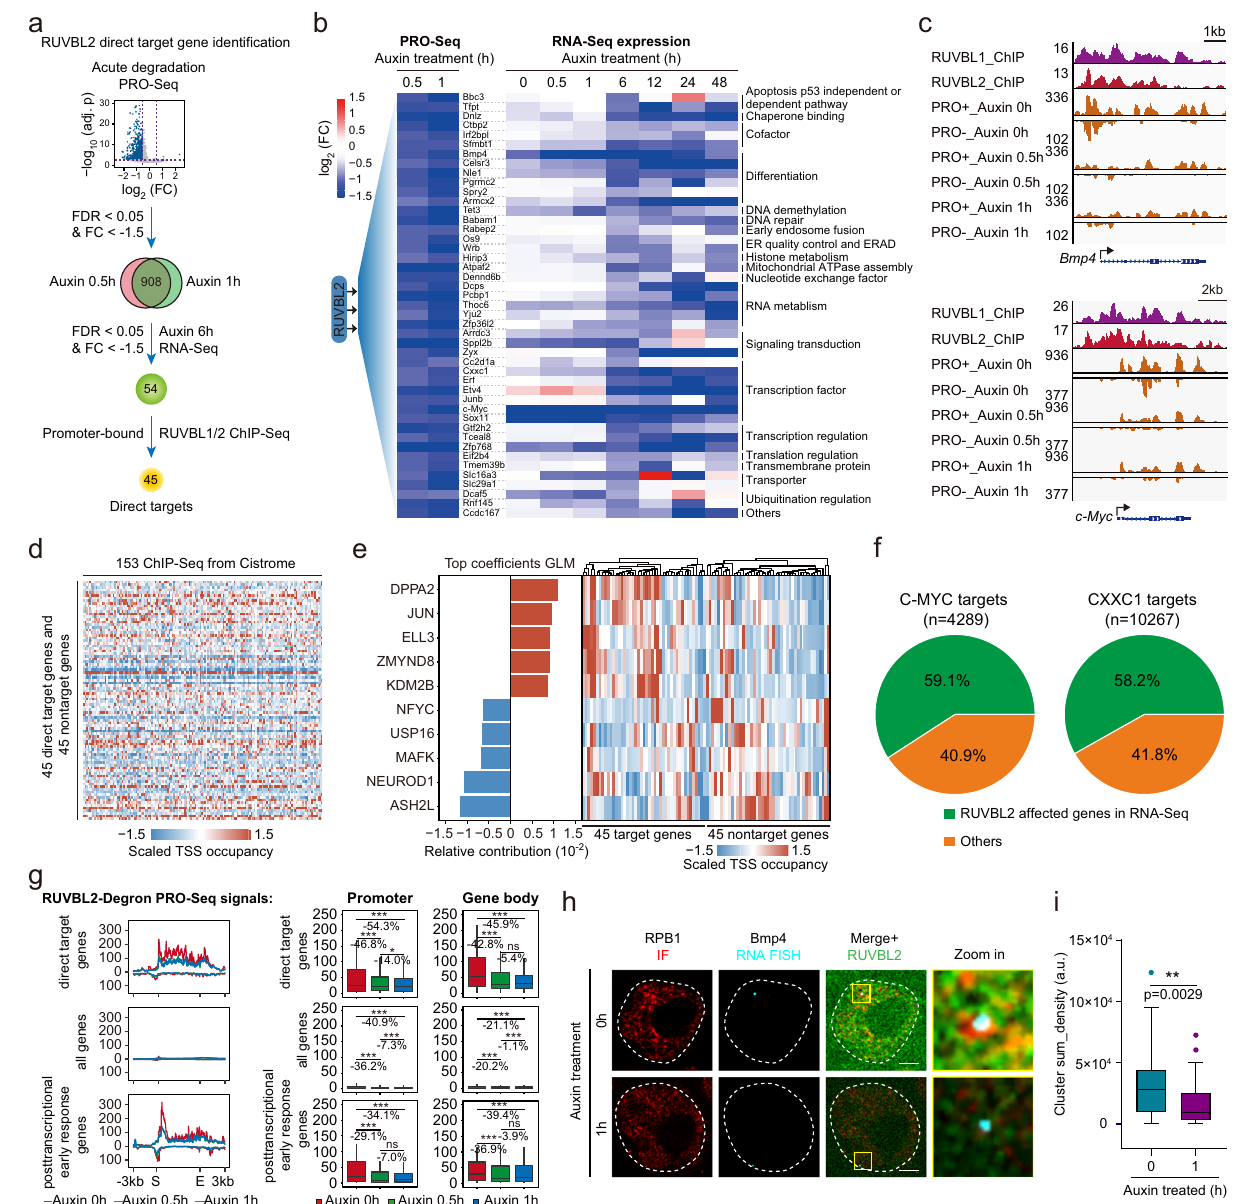
Fig. 7 | Identi fi cation of direct target genes of the RUVBL2-Pol II axis. a Work fl owof the process used to identifythe genes directly targeted by RUVBL2. The FDR are extracted from DESeq2 by adjusting p-values using BH method. b Heatmap analyses of RUVBL2 direct target genes based on PRO-Seq expression. c Snapshots showing the RUVBL1 and RUVBL2 ChIP-Seq signals and nascent RNA (PRO-Seq)signalsatthe Bmp4 and c-Myc lociafterRUVBL2degradation. d ChIP-Seq signals in the promoter regions of 45 genes directly targeted by RUVBL2 and 45 nontargeted genes in 153 datasets obtained from the Cistrome DB (Supple- mentary Data 5). e The 10 factors with the largest and smallest coef fi cients in the elastic net were selected. The heatmap shows the relative occupancy of these 10 factorsinthe45genesdirectlytargetedbyRUVBL2andin45nontargetgenes. f Pie chart indicating the percentage of C-MYC or CXXC1 ChIP-Seq-determined target genesthatoverlapthe RUVBL2-affectedgenes as determined bytheRNA-Seqdata shown in Fig. 6g. g Pro fi les of PRO-Seq signals at the gene regions of directly